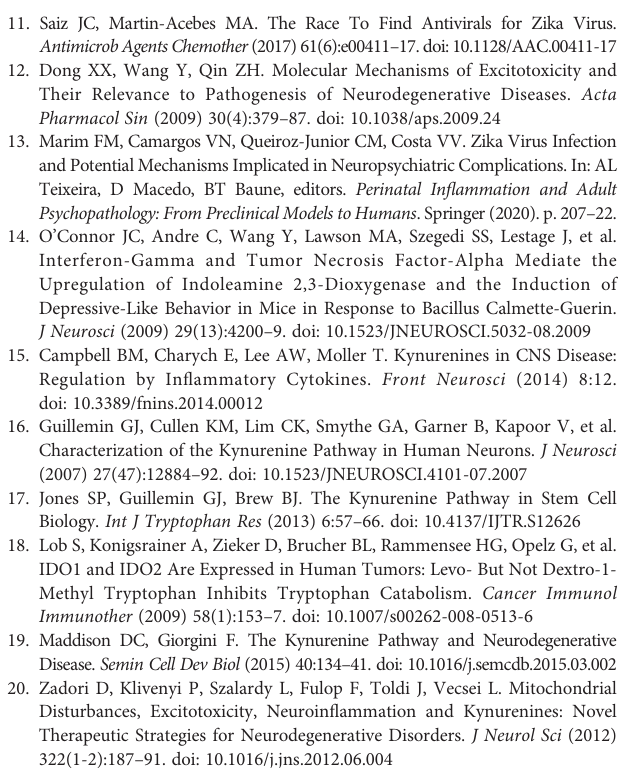
Supplementary Figure 1 | Viral load in the eye and spleen of A129 mice infected by ZIKV, treated or not with 1-MT inhibitor. A129 were inoculated (i.v) with 4x10 3 PFU/200 m L of ZIKV and treated daily with 1-MT. (A) Eye and (B) spleen was harvested forplaqueassayanalysis. Allresultsare expressedasmeanand errorbar indicatethe standard error(SEM)and arerepresentative ofatleasttwoindependent experiments. Statistically signi fi cant differenceswereassessedbyOne-way ANOVA plus Tukey ’ s comparisons